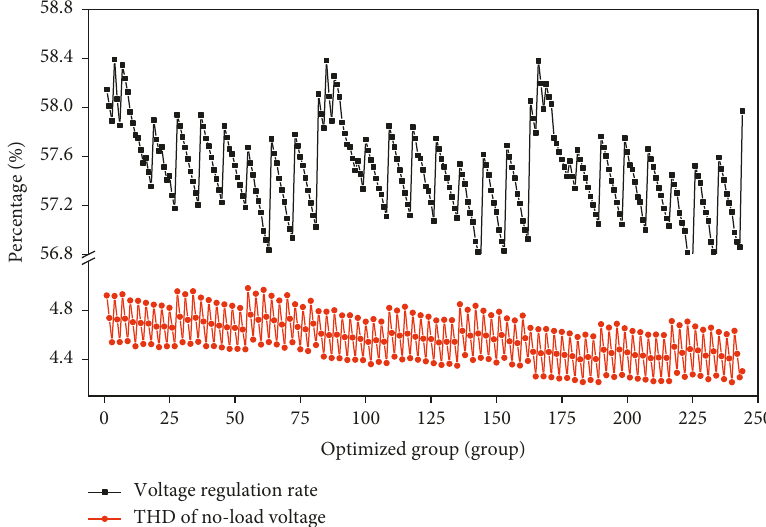
Figure 21: Variation diagrams of generator voltage regulation rate and THD of no-load voltage with different optimal groups.